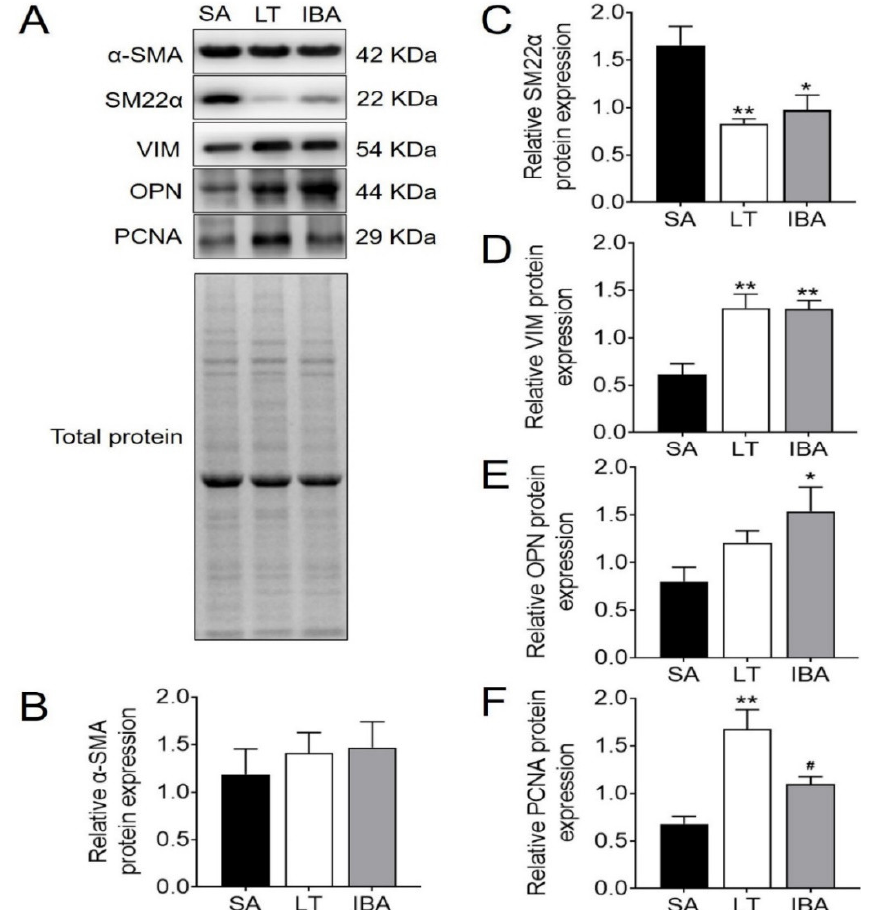
Figure 4. Expression levels of phenotype-switching related proteins in thoracic aortic SMCs. ( A ) Typical Western blot images of phenotype-switching related proteins in thoracic aortic SMCs. ( B ) Protein expression statistics of α -SMA in thoracic aortic smooth muscle. ( C ) Protein expression statistics of SM22 α in thoracic aortic smooth muscle. ( D ) Protein expression statistics of VIM in thoracic aortic smooth muscle. ( E ) Protein expression statistics of OPN in thoracic aortic smooth muscle. ( F ) Protein expression statistics of PCNA in thoracic aortic smooth muscle. SA: summer active, LT: late torpor, IBA: interbout arousal. Mean ± SEM. n = 5. Significant differences between SA conditions are denoted as follows: * p < 0.05, ** p < 0.01, whereas significant differences in IBA as compared with LT are denoted by # p <